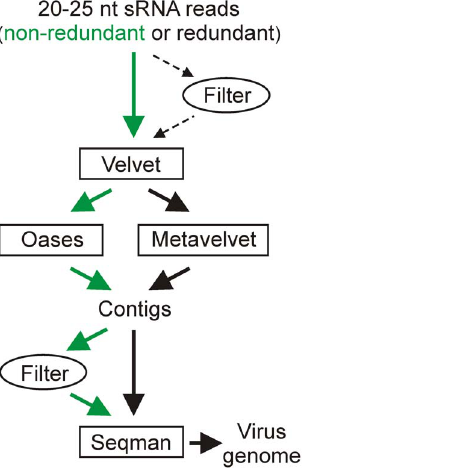
Figure 2. Bioinformatics algorithms for denovo reconstruction of viral/viroid genomes from siRNAs. The de novo assembler programs are boxed. Green arrows indicate the algorithm which in many cases generated the longest contigs.